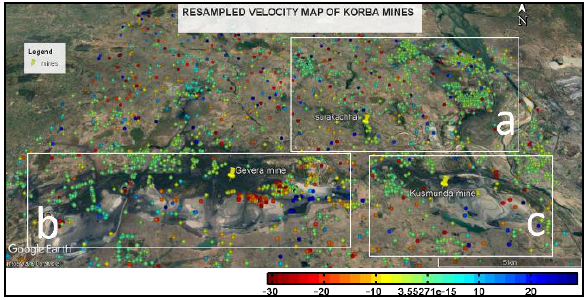
Figure 4 Resampled velocity map superimposed to Google Earth. The rectangle area are the mines (a) Surakachhar, (b) Gevera and (c) Kusmunda